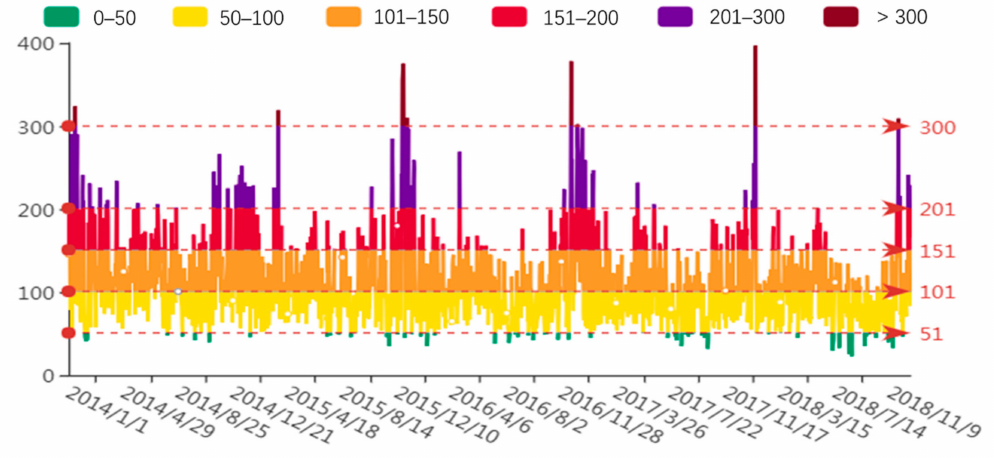
Figure 4. Variations in the daily average AQI in Weifang from